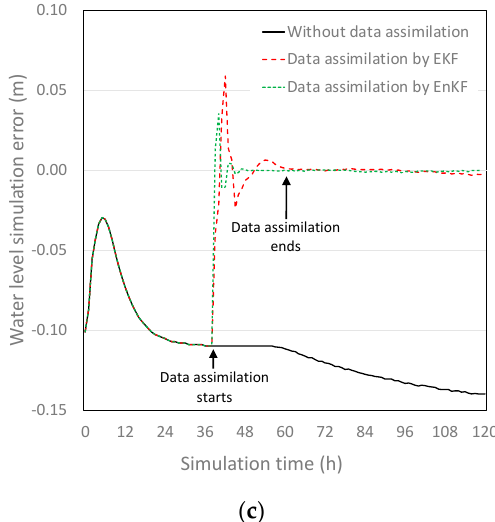
Figure 8. Water level simulation errors among different data treatment schemes at ( a ) Hongqiao station, ( b ) Lecheng station, and ( c ) Liushi station. The solid black line represents the data that were not treated via data assimilation; the green dashed line represents the data that were treated via EnKF; the red dashed line represents the data that were treated via EKF. Table 8. Comparison of evaluation metric results for EKF and EnKF in Case 2.